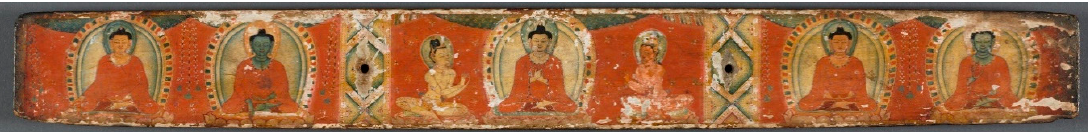
Figure 11. From left to right, Ratnasambhava, Ak ṣ obhya, Vairocana (with attendants), Amit ā bha, and Amoghasiddhi—The Five Tath ā gata of tantric Buddhism, top cover. Perfection of Wisdom in Eight Thousand Lines: A ṣṭ as ā hasrik ā Prajñ ā p ā ramit ā -s ū tra , 1119. Nepal. Gum tempera on wood. Overall: 6.5 ×